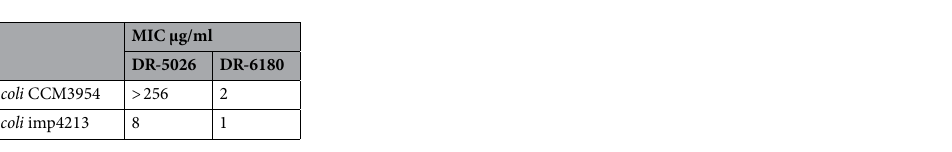
Table 2. Minimum inhibitory concentrations of LPPO I (DR-5026) and II